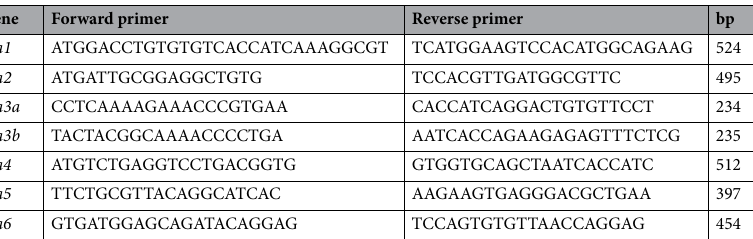
Table 1. Primer sequences. Primer sequences are given in 5 ′ –3 ′ direction, size of resulting fragment is given in base pairs (bp). Primer sequences for or genes were as described 7